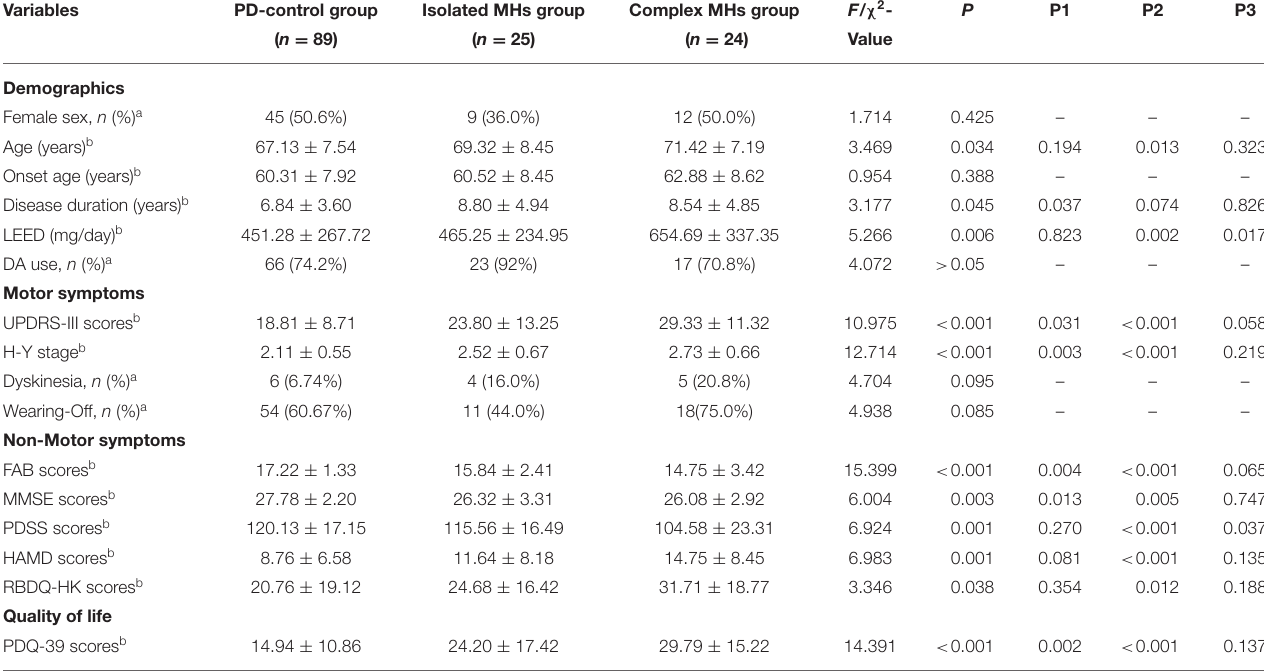
TABLE 1 | Characteristics of Chinese Parkinson’s disease patients with and without minor hallucinations.